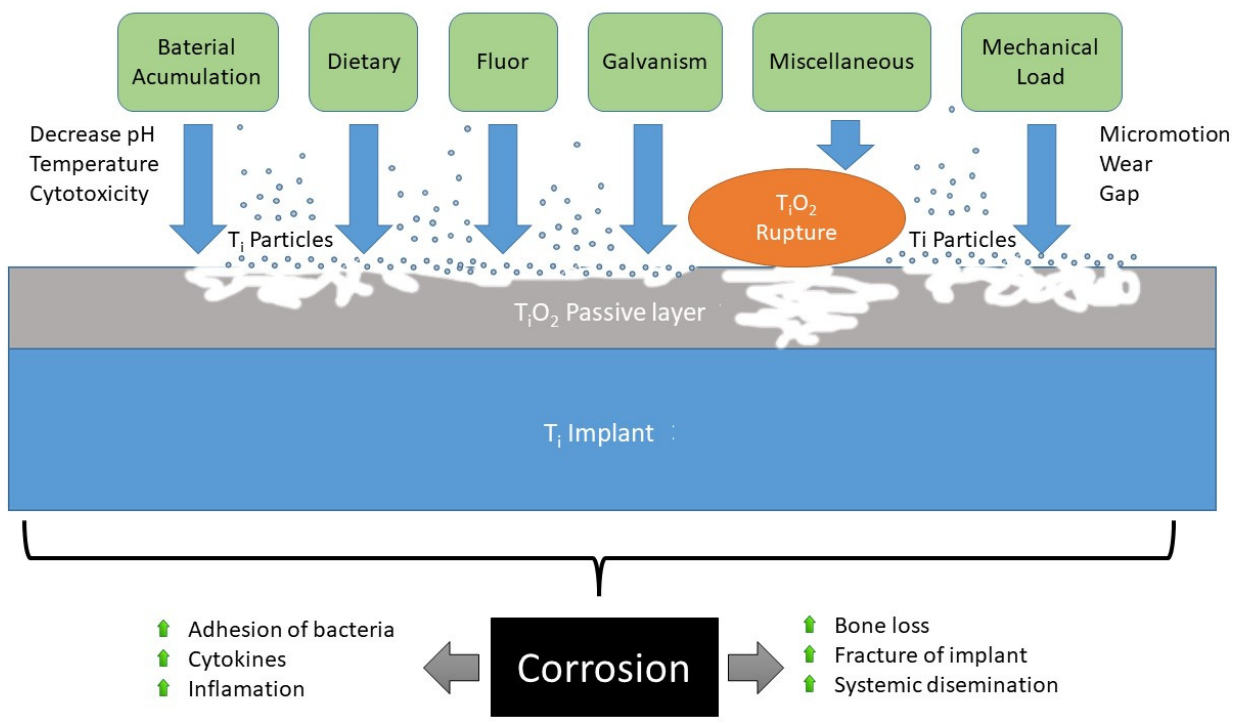
Figure 7. Diagram of the different mechanisms capable of causing Ti particle release and rupturing the passivated titanium layer.